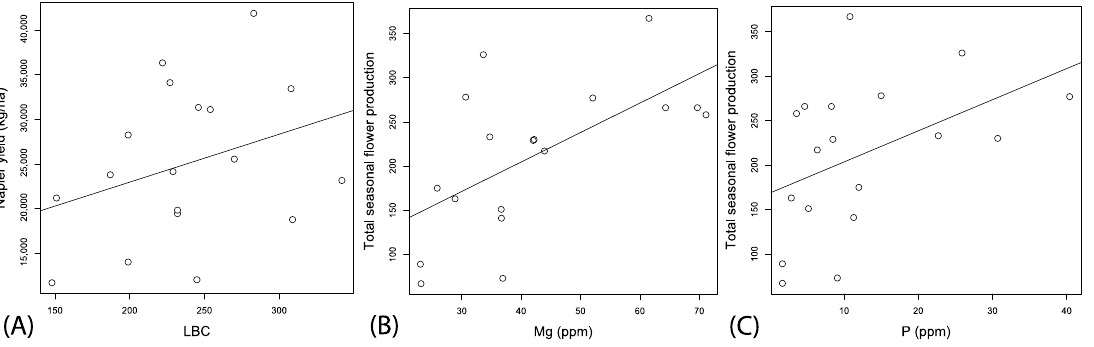
Figure 6. Correlation between estimated Napier yields from field buffer plots and LBC ( A ). Correlations between soil nutrients and total seasonal production of wildflowers pooled for the entire plot in relation to Mg ( B ), and P ( C ).